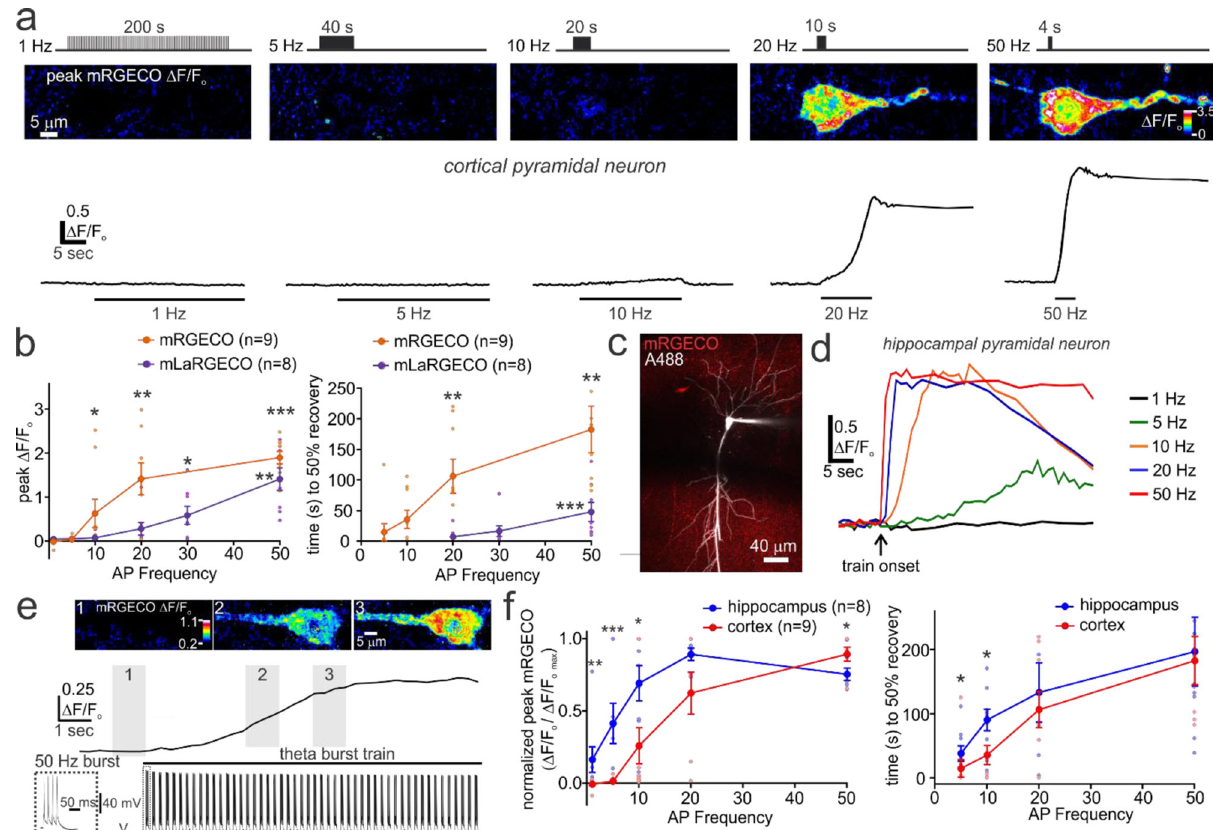
Fig. 3 The coupling between activity and mitochondrial Ca 2 + loading in pyramidal neurons is dependent on action potential fi ring frequency and varies between brain regions. a Upper , Images depict the peak fl uorescence change of mRGECO from a current-clamped cortical pyramidal neuron delivered action potential trains of progressively increasing frequencies. Stimuli of frequencies >5 Hz produced large and protracted elevations of mitochondrial Ca 2 + . All trains were comprised of 200 action potentials elicited by 200 current pulses ( + 2 nA, 5 ms). Lower , Traces depict changes in mRGECO fl uorescence measured from the pyramidal neuron soma. b Left , Group data depicting the peak somatic fl uorescence change of mRGECO and the low af fi nity sensor, mLaRGECO, in relation to action potential train frequency. Peak responses at each frequency were compared to the nominal responses elicited during 1-Hz trains (mRGECO data: n = 9, N = 4; Friedman ’ s ANOVA and Dunn ’ s multiple comparisons test: 5 Hz train, p > 0.99; 10 Hz train, p = 0.029; 20 Hz train, p = 0.002; 50 Hz train, p = 0.0006; mLaRGECO data: n = 8, N = 3; Friedman ’ s ANOVA and Dunn ’ s multiple comparisons test: 5 Hz train, p > 0.99; 10 Hz train, p > 0.99; 20 Hz train, p = 0.224; 30 Hz train, p = 0.01; 50 Hz train, p = 0.003). Right , Summary data showing the signi fi cantly greater time to recovery between low and high-frequency train-evoked fl uorescence changes for mRGECO and mLaRGECO expressing neurons. For mRGECO experiments, statistical comparisons were made between responses at 5 Hz with all other frequencies ( n = 9, N = 4; Friedman ’ s ANOVA with Dunn ’ s multiple comparison test: 10 Hz train, p > 0.99; 20 Hz train, p = 0.0042; 50 Hz train, p = 0.0021). For mLaRGECO experiments, statistical comparisons were made between the response to the 10 Hz train and all other frequencies ( n = 8, N = 3; Friedman test with Dunn ’ s multiple comparisons test; 20 Hz train, p > 0.99; 30 Hz train, p = 0.0995; 50 Hz train, p = 0.0002). c Patch-clamped and dye (A488) fi lled mRGECO expressing hippocampal CA1 pyramidal neuron. d Representative traces from a CA1 pyramidal neuron showing somatic mRGECO fl uorescence changes in response to action potential fi ring frequencies greater than 1 Hz. e A CA1 pyramidal neuron showing progressive mitochondrial Ca 2 + accumulation ( Upper ) when stimulated to fi re action potential bursts applied at theta frequency (50 Hz bursts at 5 Hz) ( Lower ). f Left , Relationship between the train-evoked peak mRGECO responses and spike fi ring frequency in cortical (data set repeated from panel B) and hippocampal pyramidal neurons. The hippocampal data set included cells from the CA1 and CA3 subregions. For each neuron, the peak responses at each train frequency were normalized to the largest evoked response out of the series of action potential trains. Normalized peak responses are signi fi cantly greater in hippocampal vs cortical neurons during low frequency fi ring (cortex: n = 9, N = 4; hippocampus: n = 8, N = 5; Mann-Whitney test for all; 1 Hz train, p = 0.001; 5 Hz train, p = 0.0003; 10 Hz train, p = 0.0345; 20 Hz train, p = 0.672; 50 Hz train, p = 0.015). Right , The time to recovery from peak mRGECO response was signi fi cantly longer in neurons of the hippocampus relative to the cortex during the 5 and 10 Hz action potential trains (5 Hz train, cortex: n = 9, N = 4; hippocampus: n = 9, N = 5; Mann- Whitney test, p = 0.0142; 10 Hz train, cortex: n = 9, N = 4; hippocampus: n = 9, N = 5; Mann-Whitney test, p = 0.0244; 20 Hz train, cortex: n = 9, N = 4; hippocampus: n = 7, N = 5; unpaired t test, p = 0.611; 50 Hz train, cortex: n = 8, N = 4; hippocampus: n = 8, N = 5; unpaired t test, p = 0.71). Summary data presented as the mean ± SEM. * P < 0.05, ** P < 0.01, *** P < 0.001. The number of cell replicates is shown in the graphs as well as the ‘ n ’ value in the text. The number of animal replicates is represented by the ‘ N ’ spike frequency and mitochondrial Ca 2 + uptake to determine the potential trains (1 & 5 Hz), no apparent changes in the somatic relevance of the MCU to discrete fi ring intensities. mRGECO mitochondrial Ca 2 + signals were detected throughout the dura- tion of stimulus (Fig. 3a, b). In contrast, the same number of expressing cortical pyramidal neurons were patch-clamped and action potentials applied at 10 Hz or greater resulted in rapid action potential trains were evoked at progressively increasing and large increases in mitochondrial Ca 2 + (Fig. 3a, b). These frequencies (1, 5, 10, 20, and 50 Hz). During low-frequency action